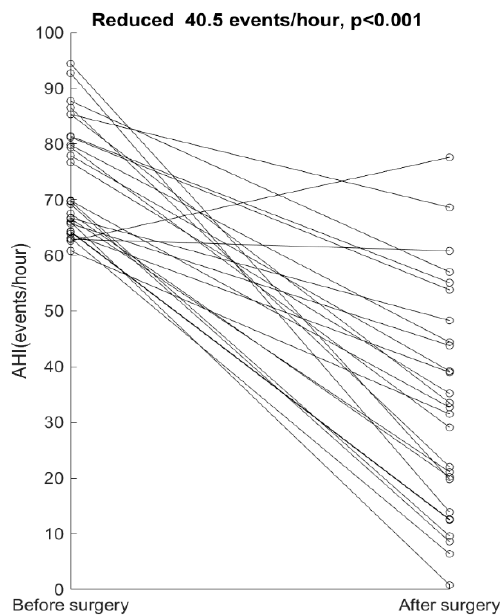
Figure 1. Individual apnea-hypopnea-index (AHI) changes revealed a significant reduction after the surgery.